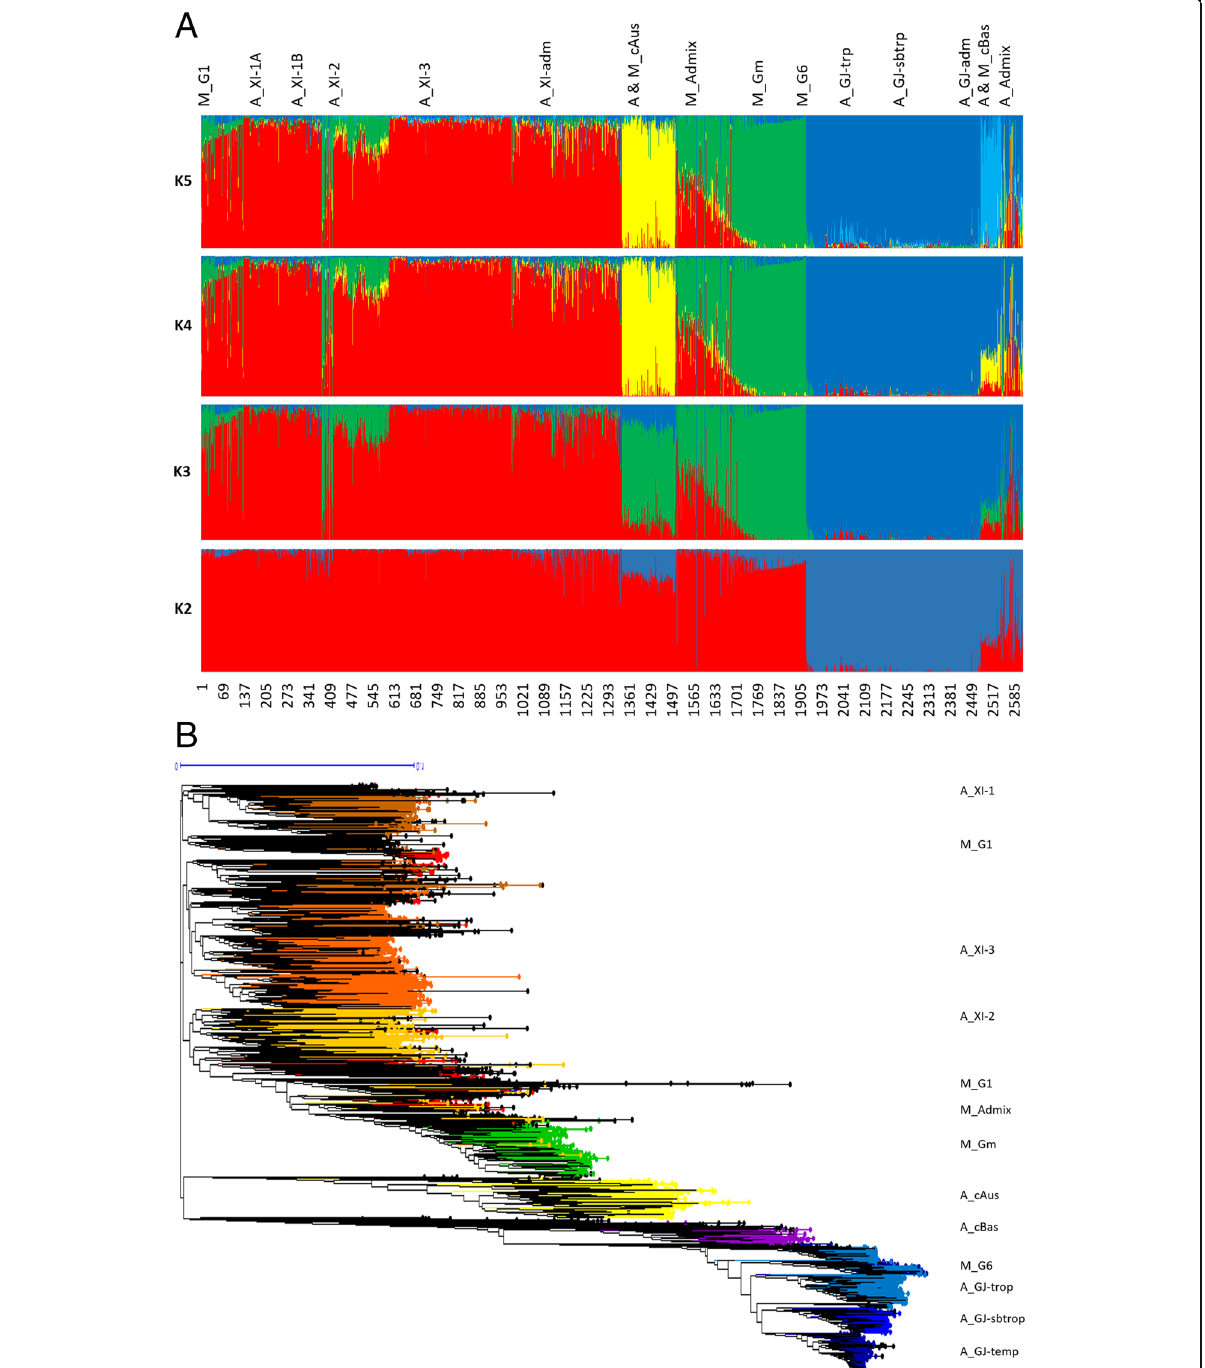
Fig. 1 Population structure in 1929 Asian and 620 Malagasy rice accessions estimated from 23,981 genome wide SNPs. a : output of sNMF for K = 2 to K = 5. From top to bottom, the Asian accessions (prefix A) are organised first by their classification in Wang et al. 2018 groups and subgroups, then by alphabetic order of country (not shown). Malagasy accessions (prefix M) are organised first by groups identified by sNMF with K = 3, then by increasing values of ancestry coefficient. b Unweighted neighbour-joining tree of simple matching distances. Tree branches are coloured according to membership in sNMF groups at K = 3 and ancestry coefficient 0.8, for Malagasy accessions, according to Wang et al. (2018) subpopulations of Asian